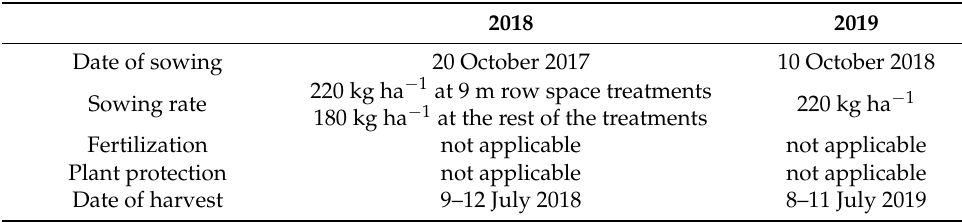
Table 7. Growing technology of triticale of the harvesting years 2018 and